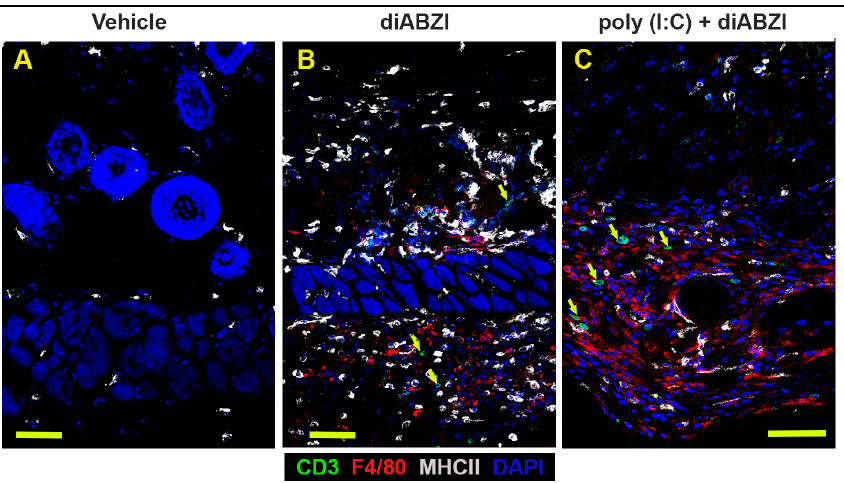
Figure 4. Immune cells infiltration in the dermis and subcutaneous layers at the injection site. Dis- tribution of CD3 T cells, F4/80 macrophages, and MHC II positive cells on day 8 at the site of injec- tion in the skin from ( A ) vehicle-treated, ( B ) diABZI-treated, and ( C ) poly (I:C)+diABZI-treated mice. ( A ) Immunofluorescence staining shows few MHC II expressing cells in the dermis of vehicle- treated mice. ( B ) Deeper layers of the dermis and the subcutaneous tissue show few CD3 T cells (arrows), an increase in F4/80 cells, and MHC II expression after diABZI-,and ( C ) poly (I:C)+diABZI- treatment (scale bar = 50 µm).